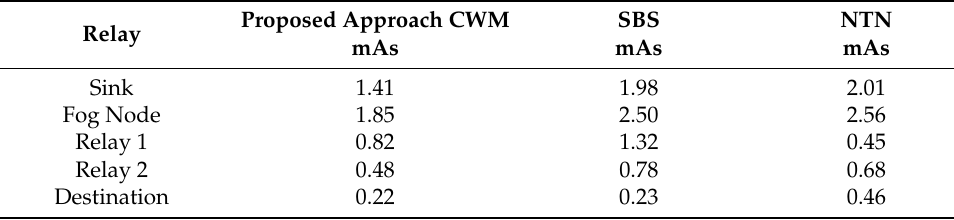
Table 4. Nodes energy consumption using 2 Relays.